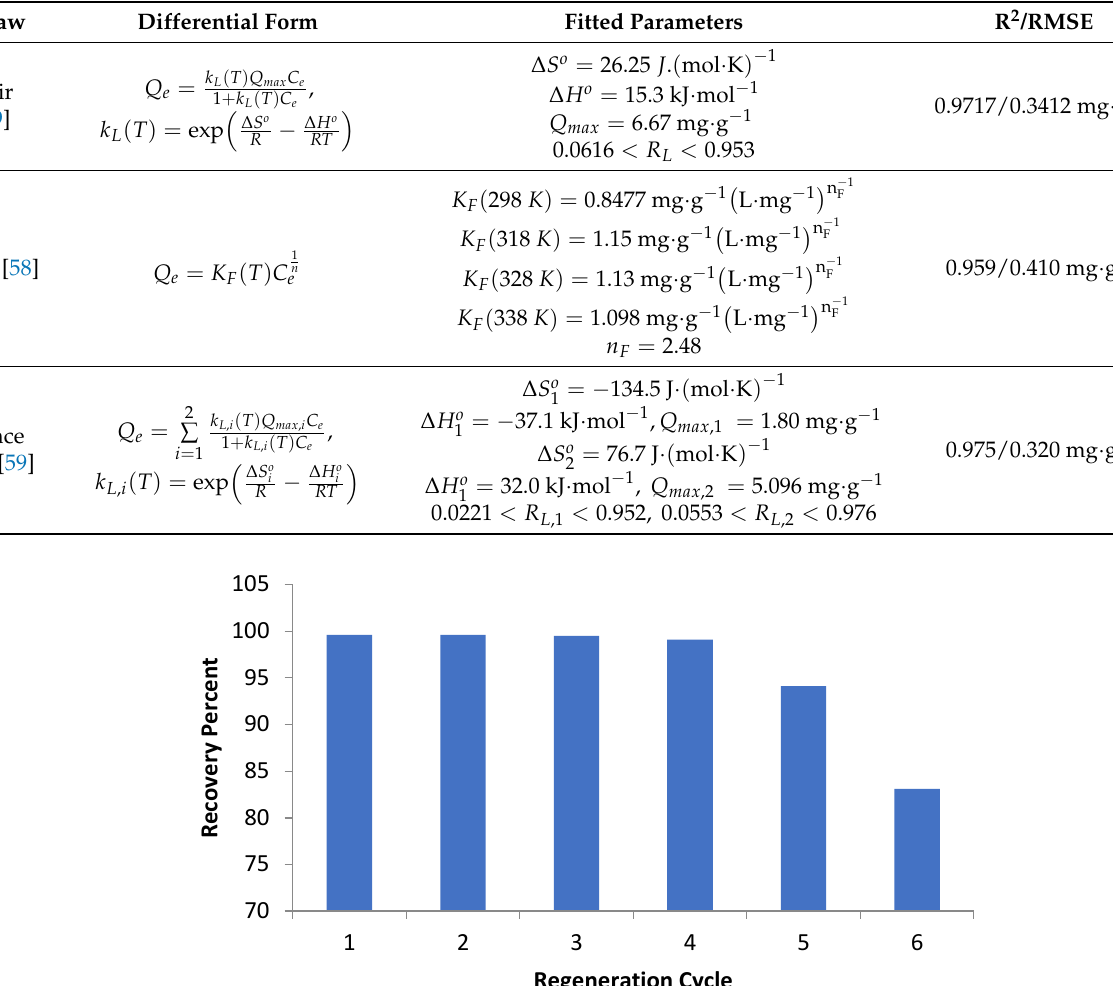
Figure 13. Recovery efficiency of PDFe/Al after Cr(VI) adsorption.